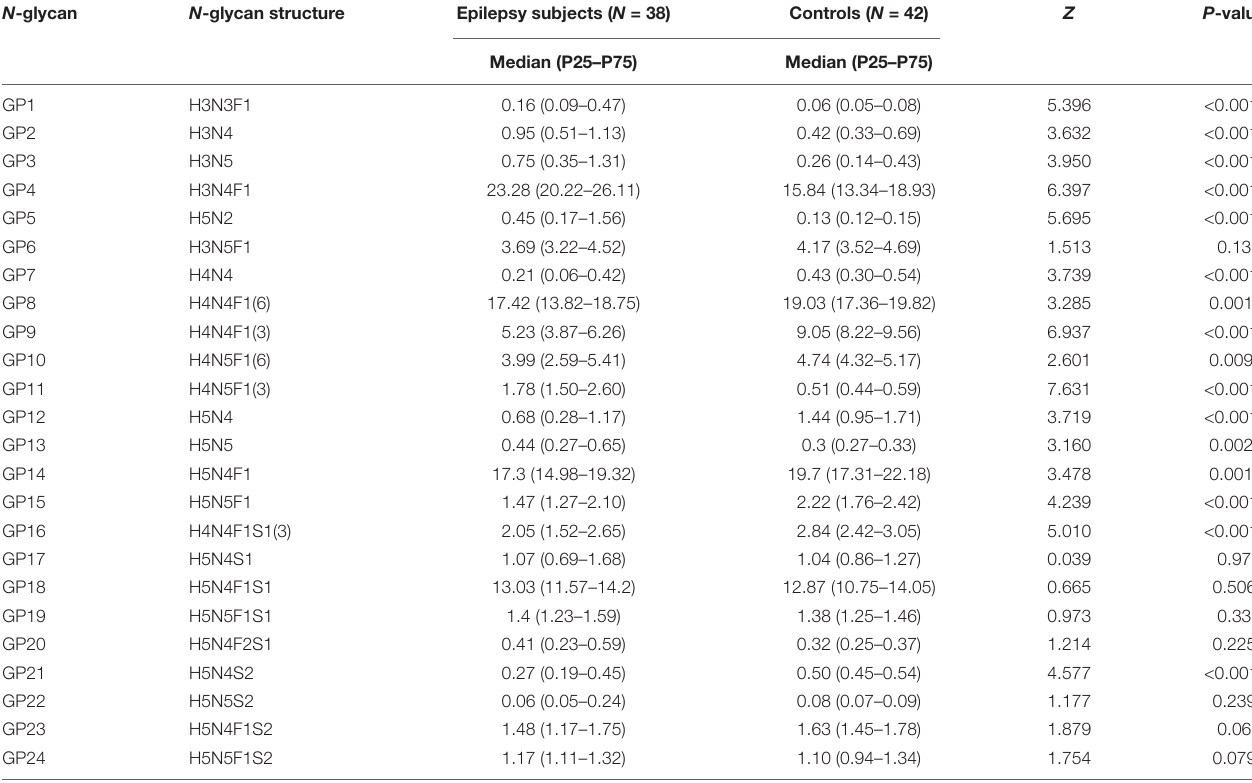
TABLE 2 | Serum N -glycan levels of epilepsy subjects and control subjects.